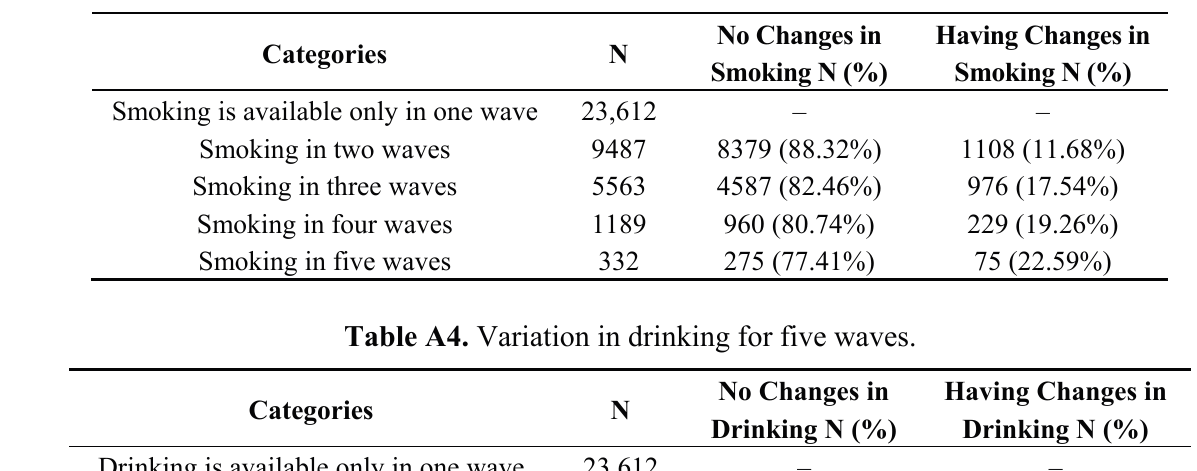
Table A3. Variation in smoking for five waves.